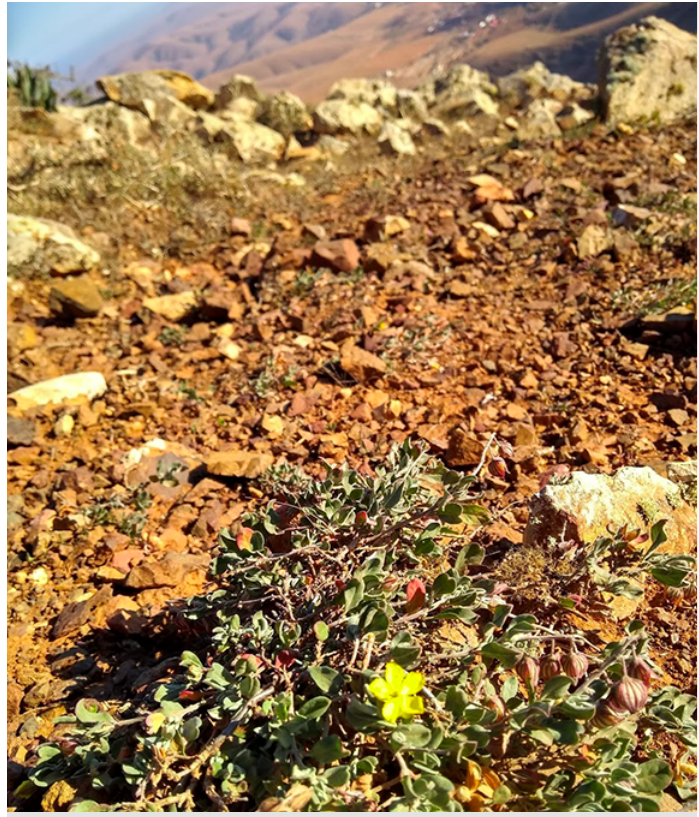
Fig. 4 Helianthemum canariensis , a host plant for Terfezia canariensis , growing in the mountains of Betancuria on the island of Fuerteventura. The photograph was taken by the corresponding